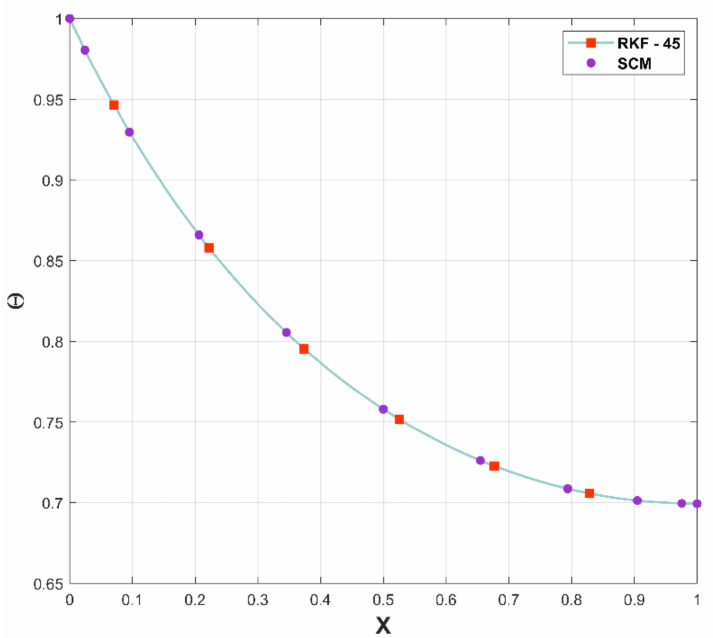
Figure 5. Comparison of the PR with RKF-45.